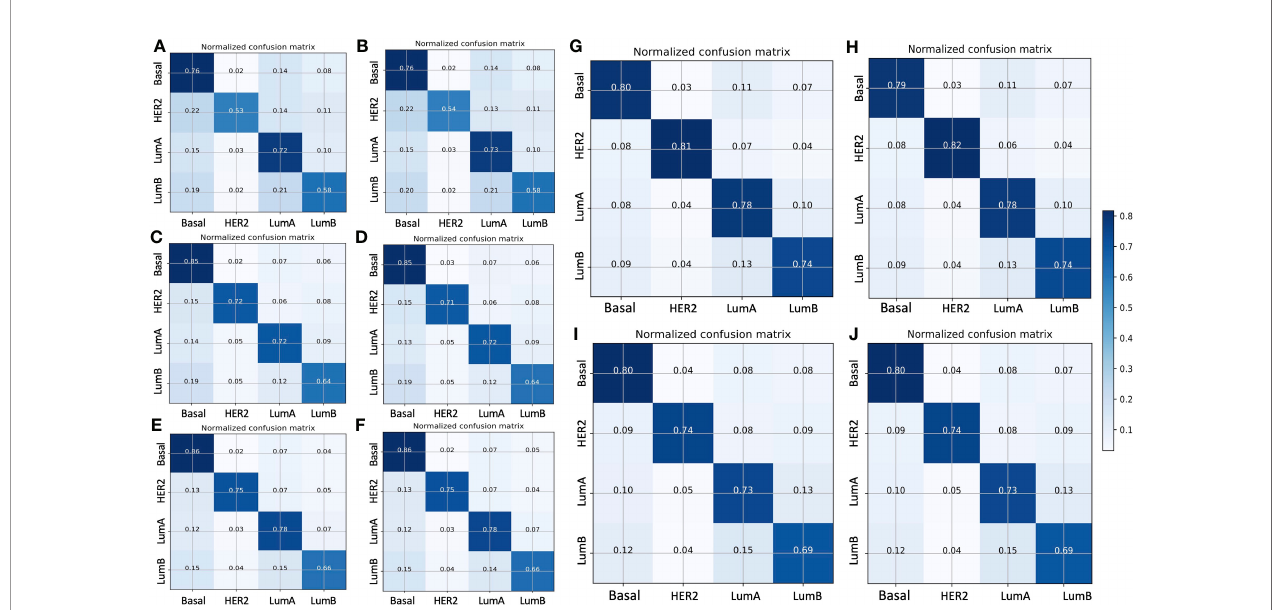
FIGURE 2 | Normalized confusion matrix of fi ve models with the validation (left panels) and testing (right panels) sets. (A, B) ResNet50 model, (C, D) VGG16 model, (E, F) Xception model, (G, H) ResNet101 model, (I, J) ResNet101_imgnet model. True and predicted subtype classi fi cations are shown on the y- and x-axes, respectively, such that the correct predictions are shown on the diagonal from the top left to the bottom right of each matrix. The blue gradient color represents the model accuracy for detecting each subtype. The darker the blue color, the better the model performance.